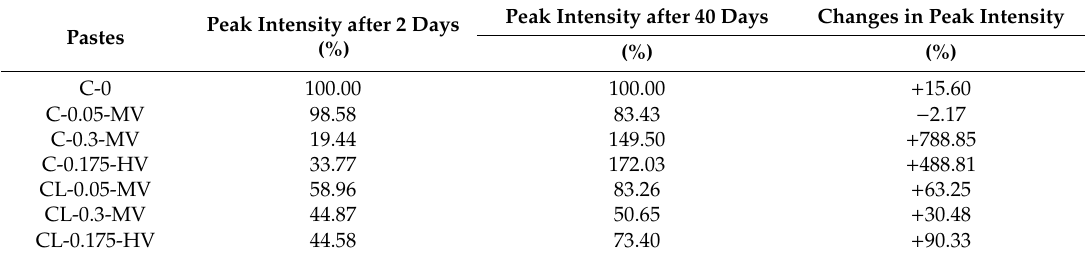
Figure 6. X-ray patterns of all pastes for 40 days. Denotation: A–alite, B–belite, Br–brownmillerit, C–calcite, E–ettringite, P–portlandite. Table 6. Percentage changes in Portlandite intensity after 2 and 40 days of maturation for all pastes (according to Table